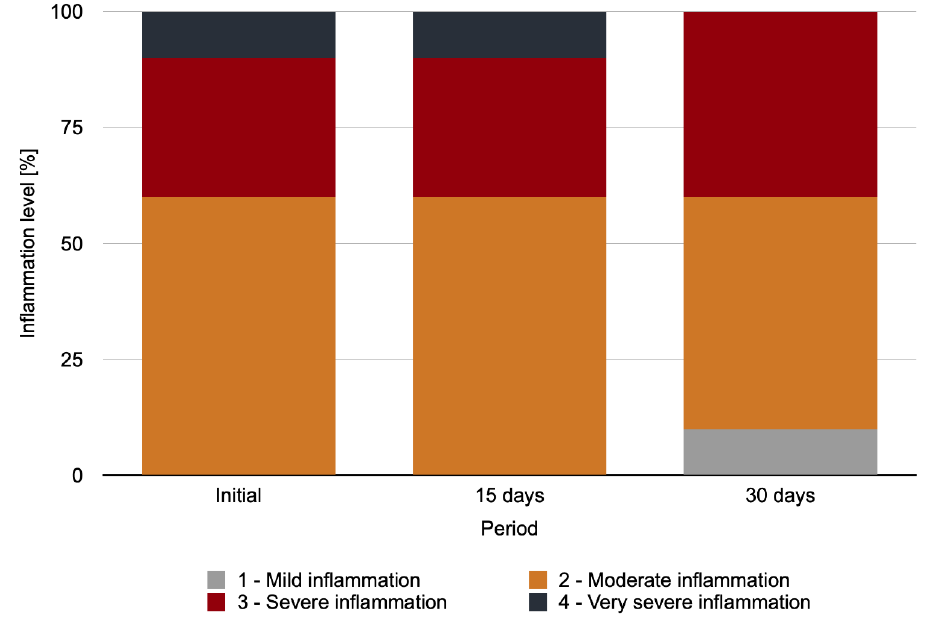
Figure 6. Percentage distribution of cytological analysis scores for the palpebral conjunctivae of the anophthalmic cavity over time in the IG.